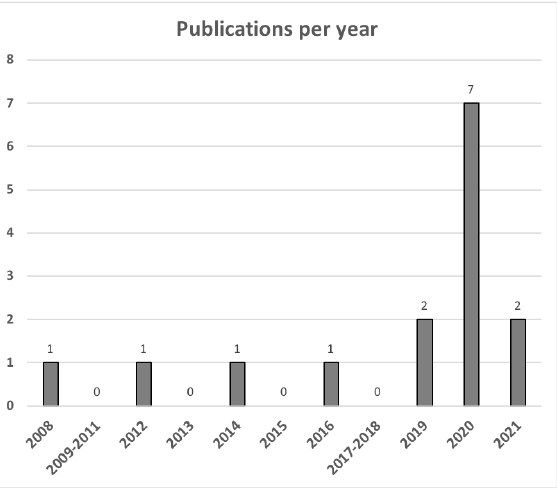
Figure 2. Trend of publication frequency of articles included in the scoping review.